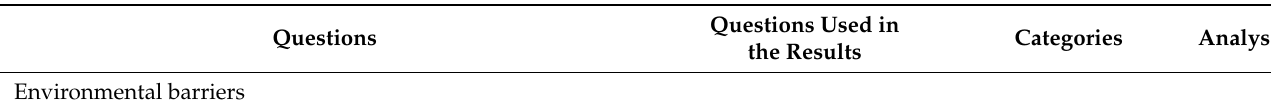
Table 1. Summary of perceived neighborhood